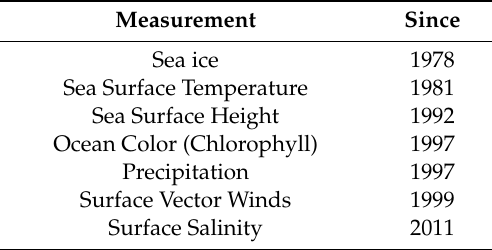
Table 1. List of oceanographic satellite measurements and the start of their continuous time series of